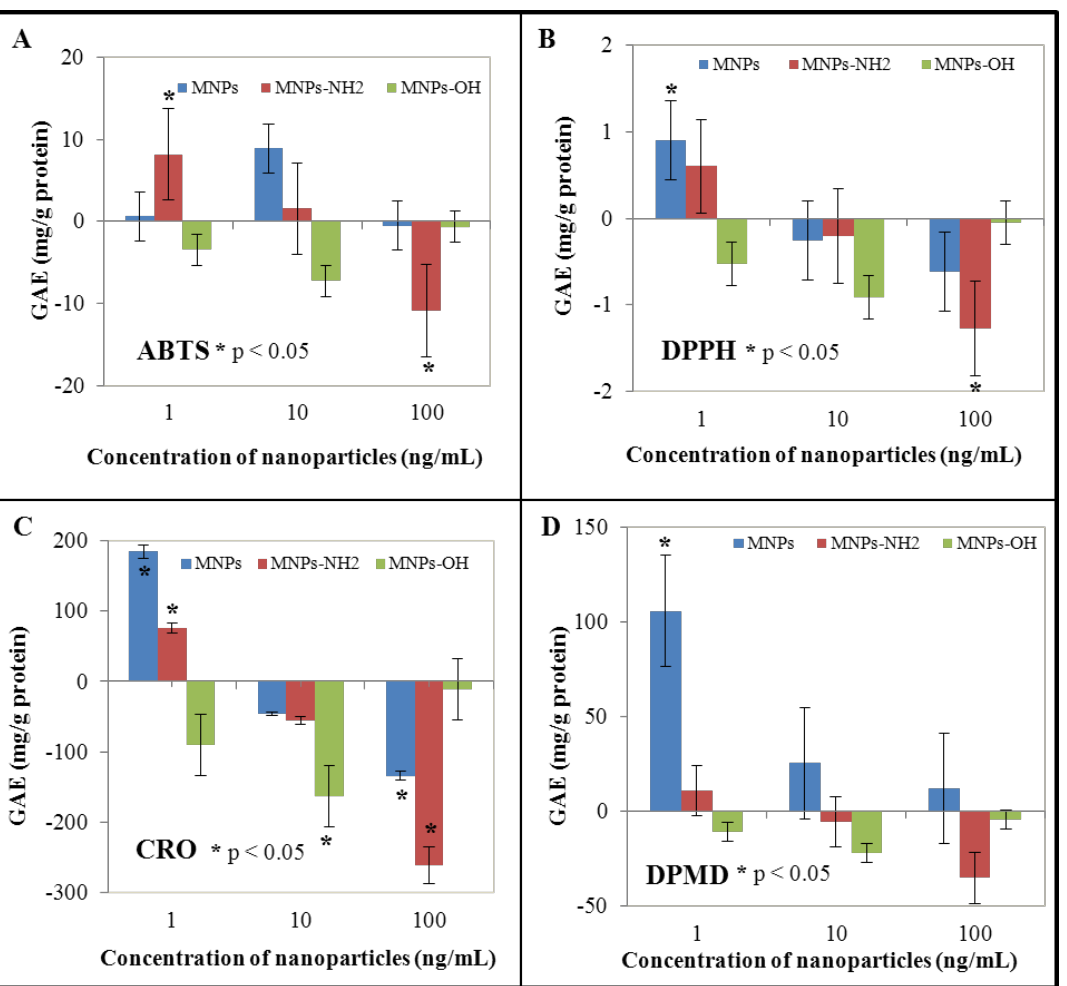
Figure 4. The influence of 0, 1, 10 and 100 ng/mL of magnetic γ-Fe (NPs) and modified magnetic nanoparticles (MNPs–Fe antioxidant activity of treated tobacco BY-2 cells measured by ( A ) ABTS, ( B ) DPPH, ( C ) CRO and ( D ) DPMD assay. The results were subtracted from the control, i.e. , non-treated BY-2 tobacco cells. The cells were treated for five